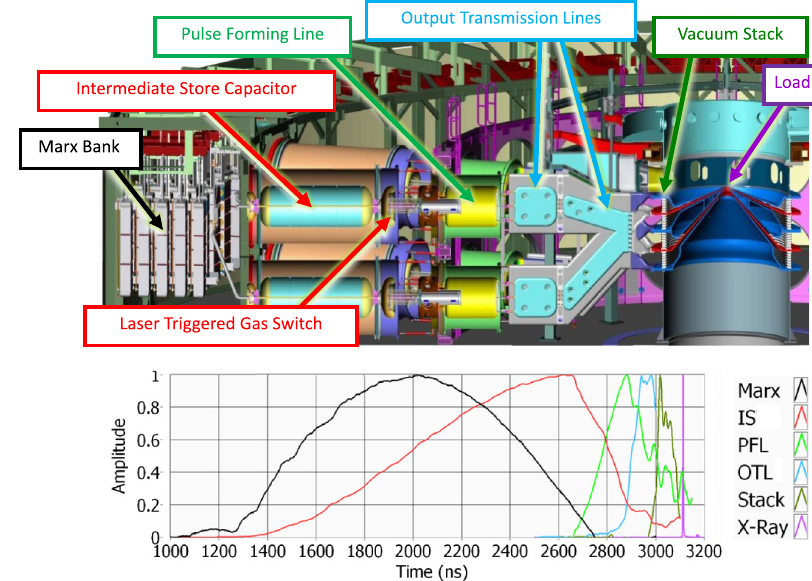
FIG. 1. Cutaway view of the pulse forming line in the Z accelerator. Capacitors, transmission lines, and switches are used to achieve a 1000:1 temporal pulse compression as the 26 MJ of stored energy are passed to the load.